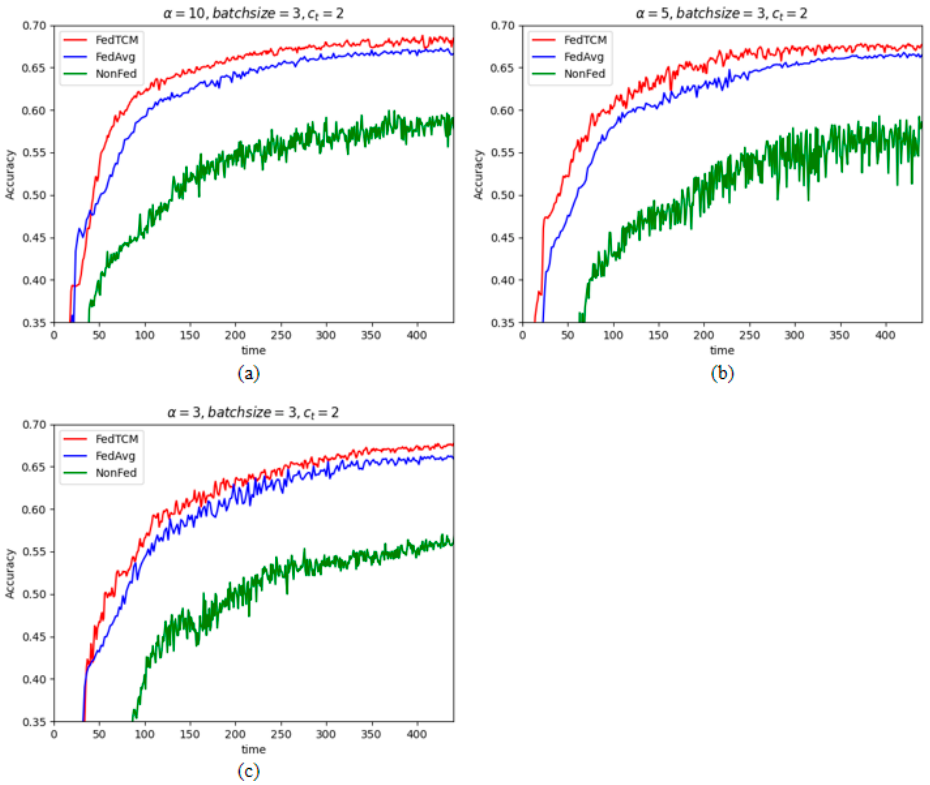
Figure 5. Comparing FedTCM with the baseline algorithms on the shopping behavior dataset at batch size 𝐵 = 3, 𝑐 (cid:3047) = 2 . ( a ) FedTCM and baseline algorithms are all set 𝛼 = 10 . ( b ) FedTCM and baseline algorithms are all set 𝛼 = 5 . ( c ) FedTCM and baseline algorithms are all set 𝛼 = 3 . With changes in the degree of data heterogeneity, NonFed does not converge. The